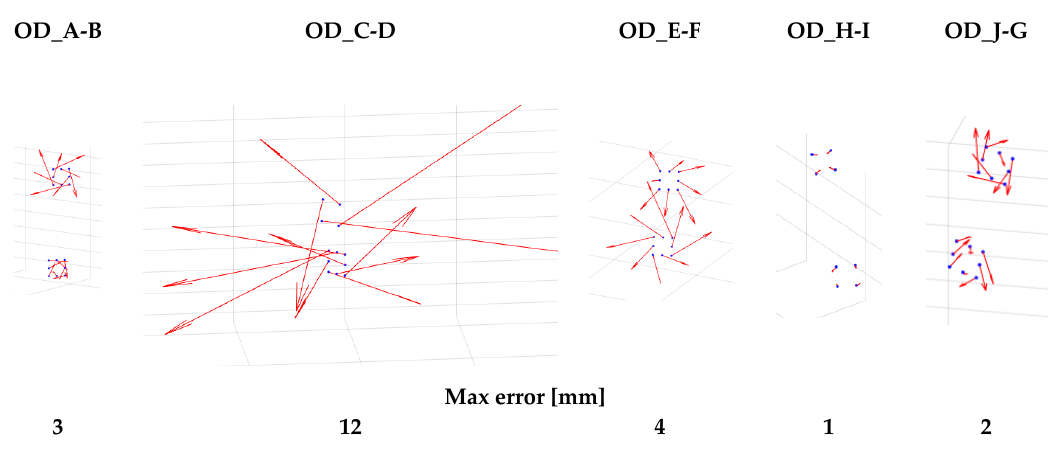
Figure 19. Results of the accuracy analysis on the pre-calibrated rod.